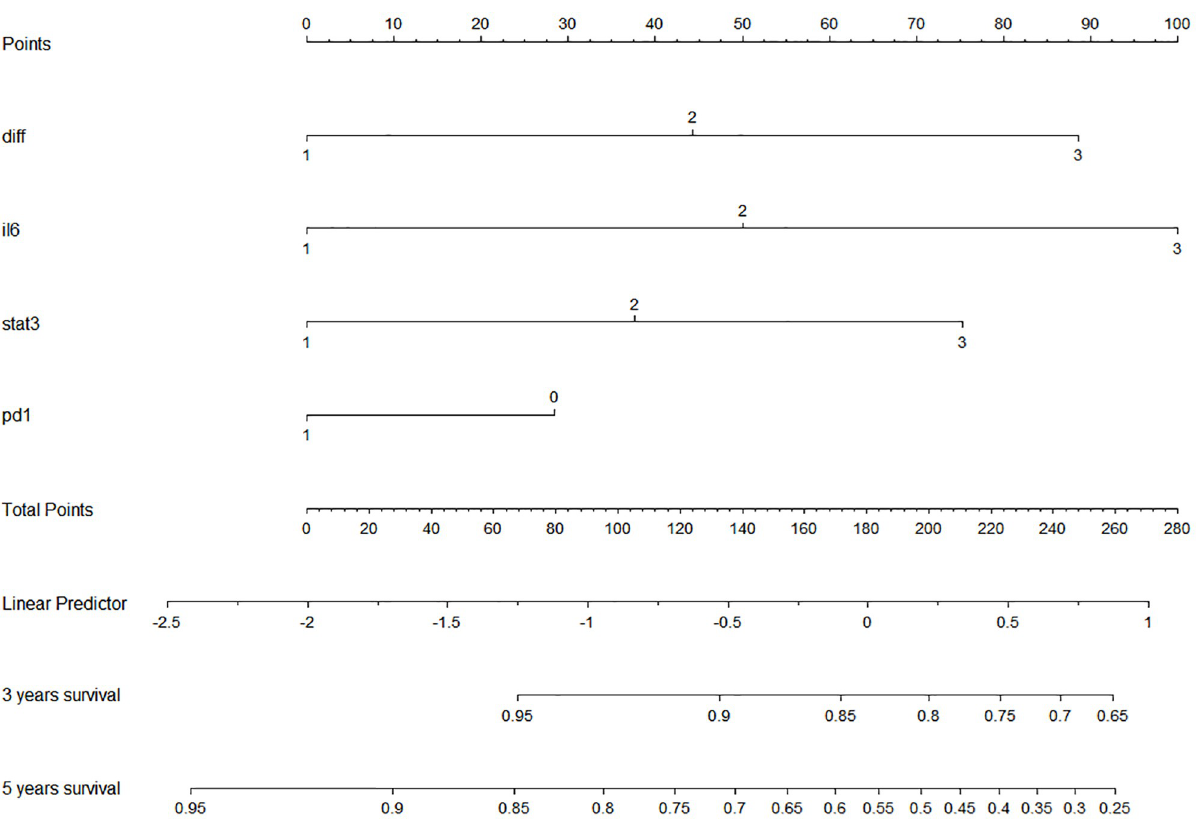
Fig 4. Column of postoperative survival of patients with gastric cancer predicted by differentiation +IL-6+ p-STAT3 +PD-1. The lengths of the differentiation, IL-6, p-Stat3, and PD-1 variables represent the contribution of that factor to the event of death in gastric cancer, upward corresponding to the scores labeled in Points. Depending on the individualized status of the patient, the scores for each variable are summed to obtain a Total Points value, and the scale is projected downward to yield a predicted survival value for that individual with gastric cancer at 3 or 5 years